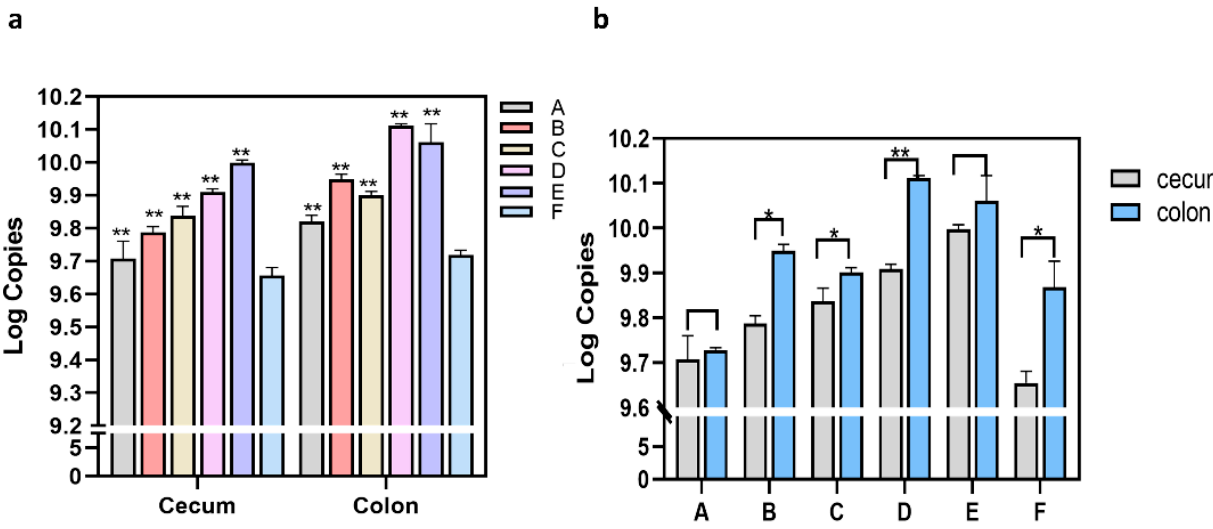
Figure 2. The level of Clostridium butyricum in the cecum and colon increased significantly after 7 consecutive days of gavage with C. butyricum . Raw data from RT-qPCR amplification were analyzed and plotted on GraphPad Prism Version 8.0 with two-way ANOVA to determine the significance. ( a ) Compared with group F, there is a highly significant increase in the colon, C. butyricum in the cecum have no significant increase on day 6 (group A) after administration. ( b ) C. butyricum is more abundant in the colon than in the cecum. Results are shown as mean ± SEM (n = 3). * p < 0.05 and ** p < 0.01 compared to the control group (group F). A: Day 6th after administration; B: day 4th after administration; C: day 2nd